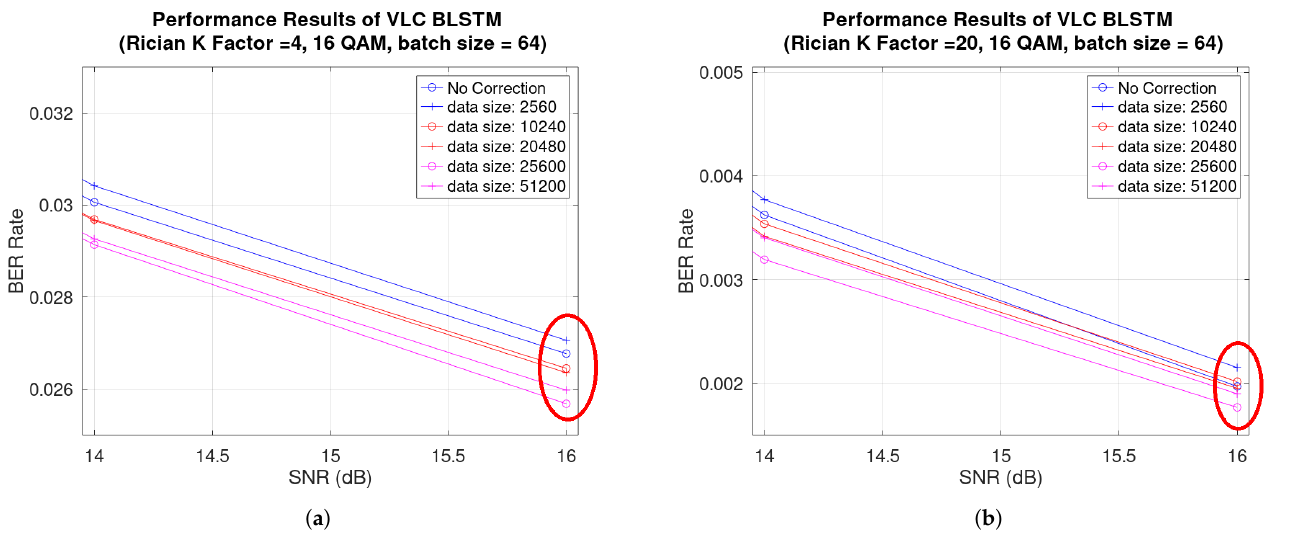
Figure 14. BER performances over data size with Rician fading channel 16 QAM for white LED: ( a ) K factor = 4; ( b ) K factor = 20.